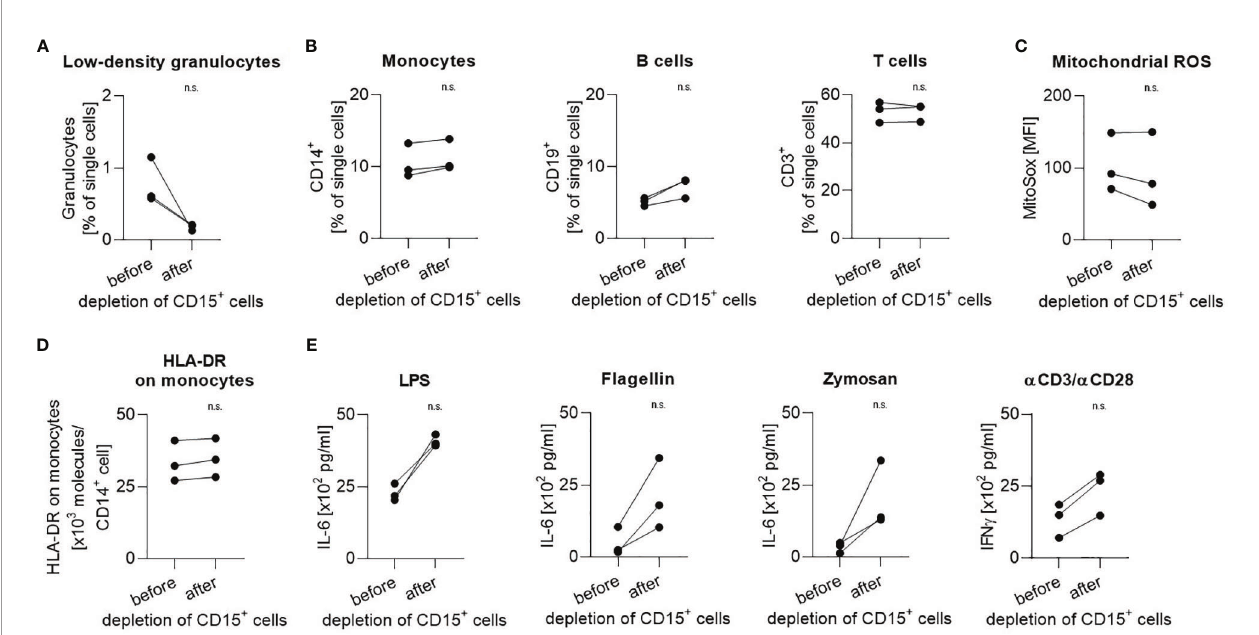
FIGURE 4 | Handling during depletion has no impact on cellular function. Proportion of (A) low-density granulocytes, (B) monocytes, B cells, and T cells in all single cells before and after depletion of CD15 + cells. (C) Mitochondrial ROS expression level and (D) number of HLA-DR molecules per CD14 + monocyte before and after depletion of CD15 + cells. (E) Induced IL-6 production in response to stimulation with LPS, fl agellin, or zymosan and induced IFN g production in response to stimulation with human T-Activator CD3/CD28. Each data point represents a separate healthy volunteer (n=3). Paired results from the same donor before and after depletion of CD15 + cells are connected by a line. Group comparisons were performed using Mann-Whitney test (n.s., not signi fi